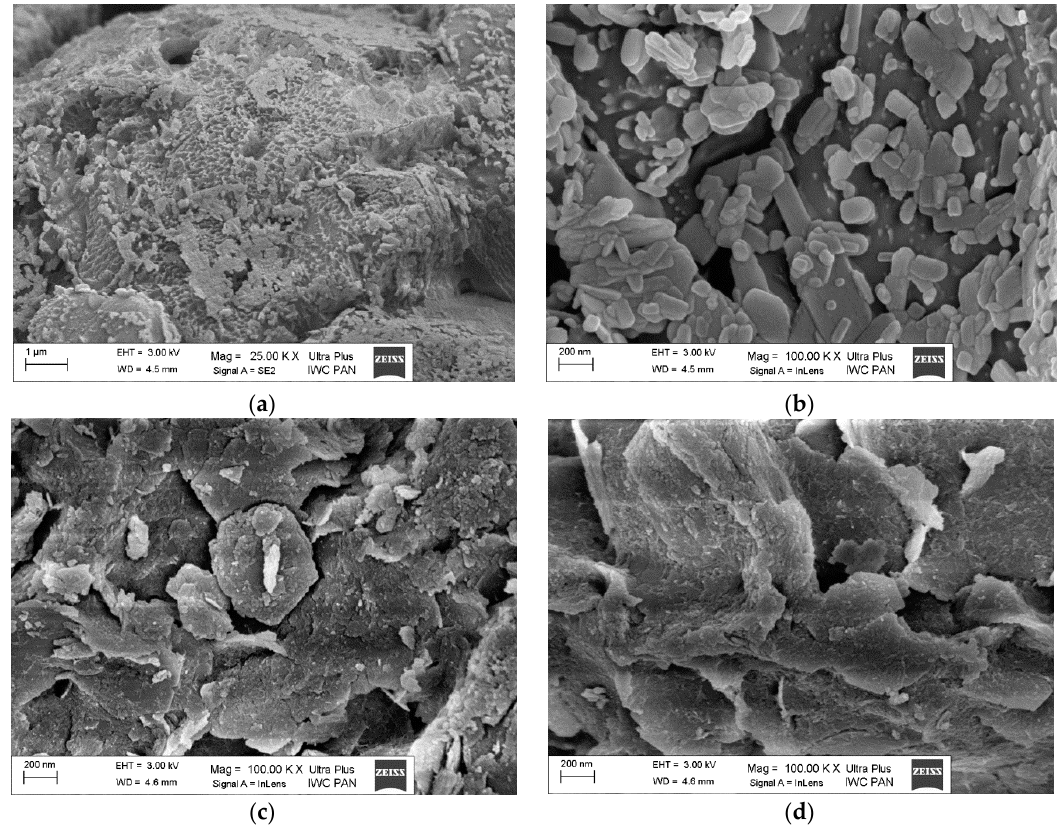
Figure 5. SEM micrographs of lawson ( a , b ), LH ( c ) and LH/lawson pigment ( d ).